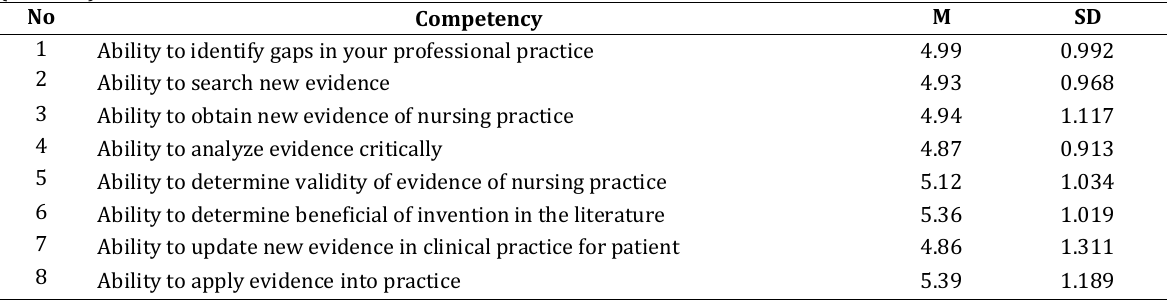
Table 2. Mean score and standard deviation of students’ competency in implementing EBP in clinical practice (n = 120)